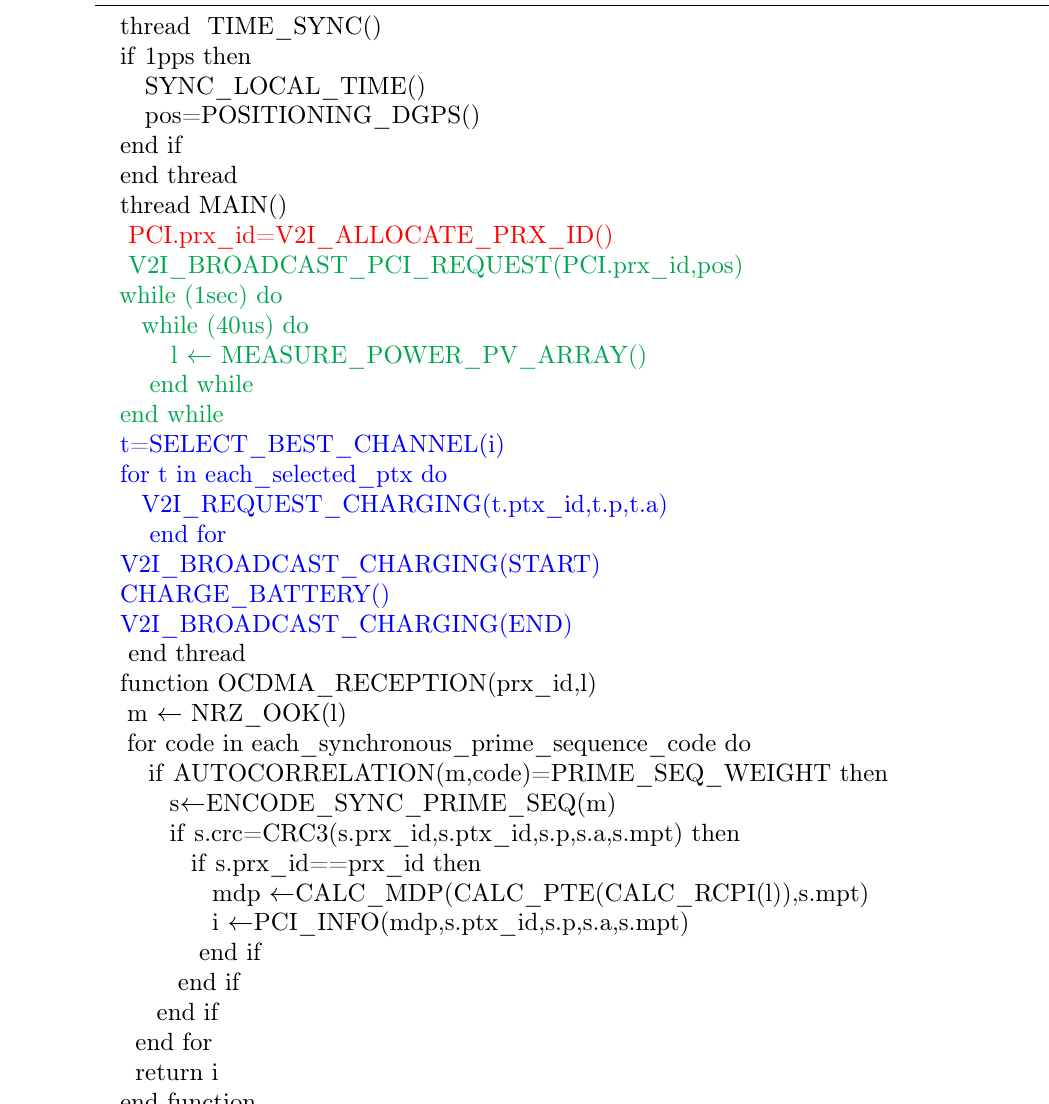
Algorithm 2 PRX operation